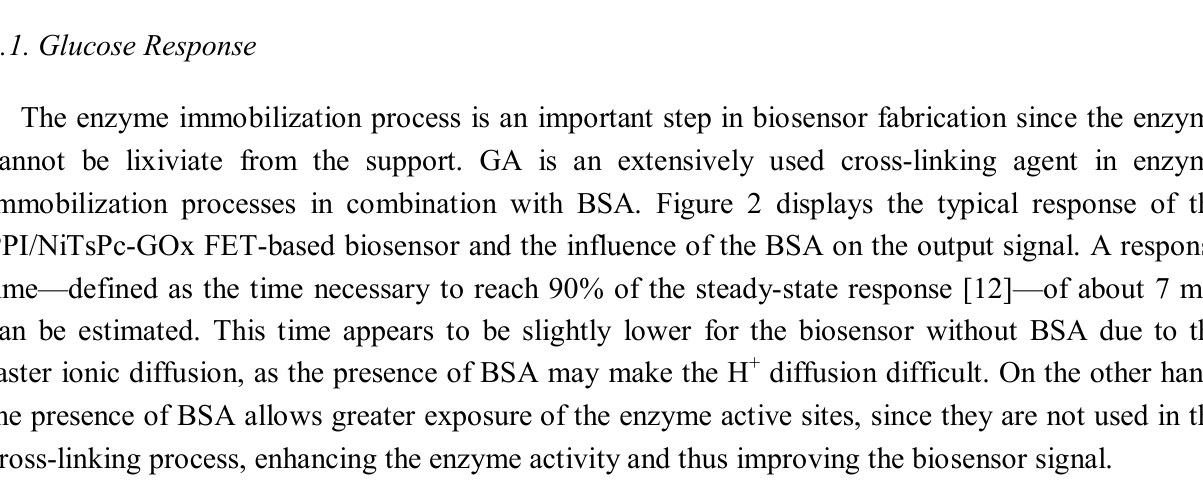
Figure 2. Response of PPI/NiTsPc-GOx FET-based biosensor with (black line) and without (red line) the presence of BSA in the process of enzyme immobilization to detect 0.5 mM of glucose. Measurement conditions: buffer solution 10 mM, pH